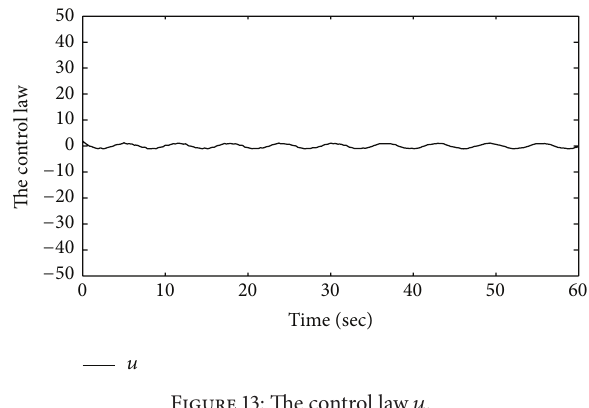
Figure 13: The control law 𝑢